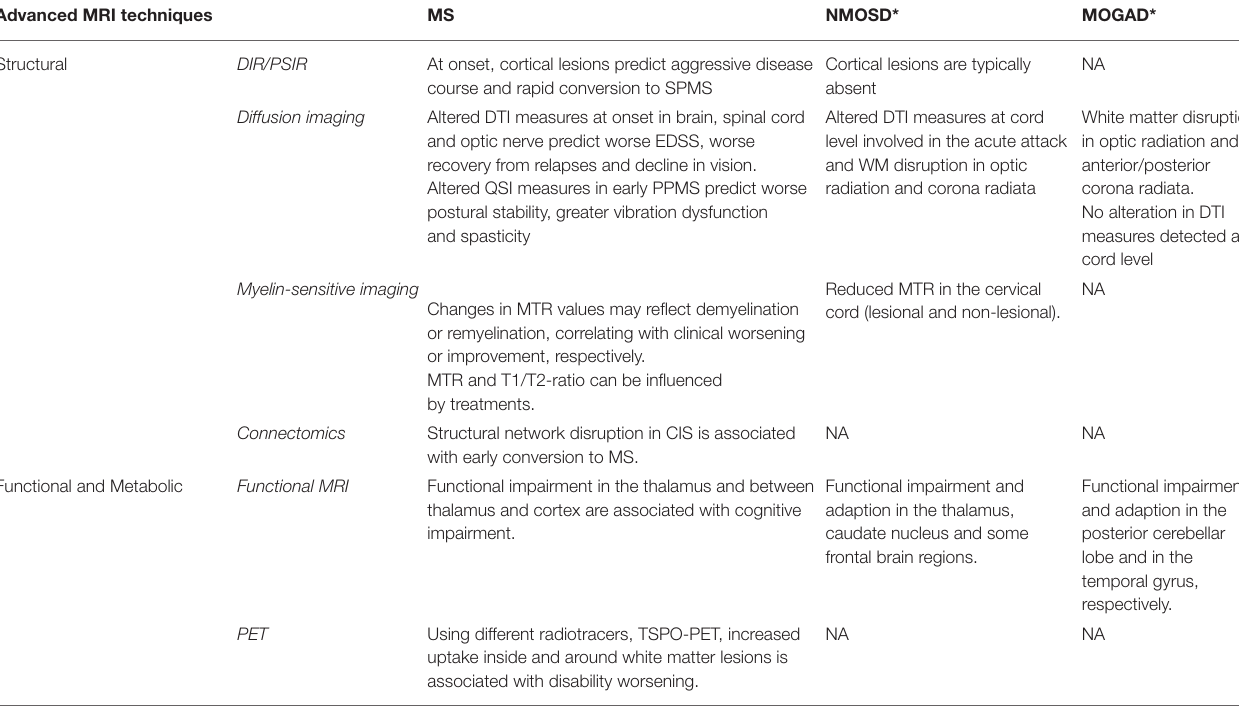
TABLE 2 | Advanced MRI measures reflecting different pathogenic mechanisms with a potential prognostic role on clinical disability in multiple sclerosis (MS), neuromyelitis optica spectrum disorder (NMOSD), and myelin oligodendrocyte antibody disease